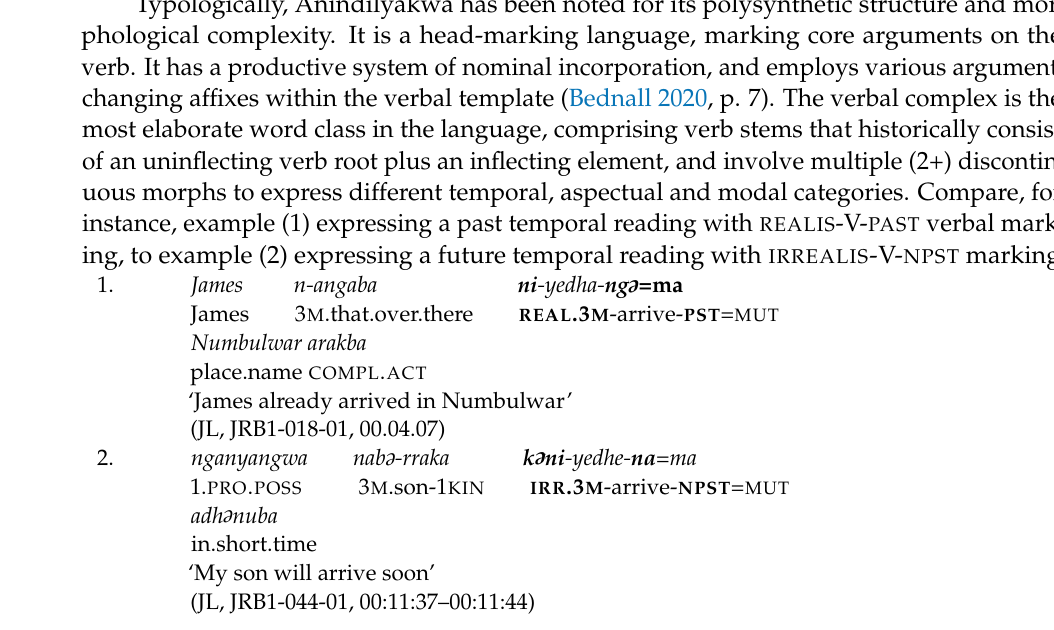
Figure 1. Languages of norther Australia (Harvey 2008).